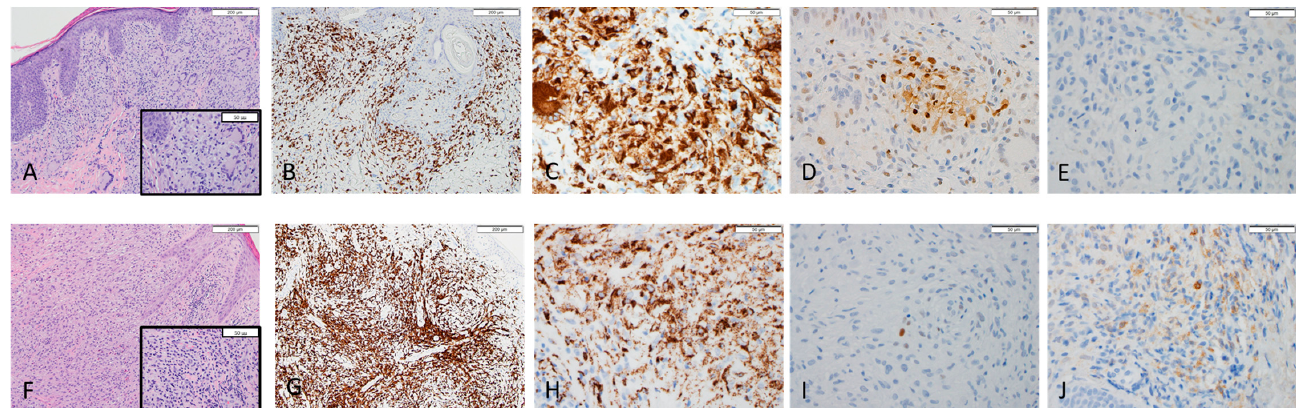
Figure 1. Case #2 skin biopsy with M1 predominancy ( A – E ); the biopsy demonstrates dense dermal proliferation of mixed cells including neoplastic lymphocytes and abundant histiocytes; many multi-nucleated giant cells are seen ( A , inset × 40). Immunostain of CD3 shows interstitial infiltraTable 68. highlights histiocytes and multi-nucleated giant cells ( C ); pSTAT1 is positive for a cluster of M1 macrophage ( D ) while CD163 for M2 is completely negative I. Case #3 skin biopsy with M2 predominancy ( F – J ); the biopsy demonstrates tumor stage of mycosis fungoides. The neoplastic T lymphocytes is in a